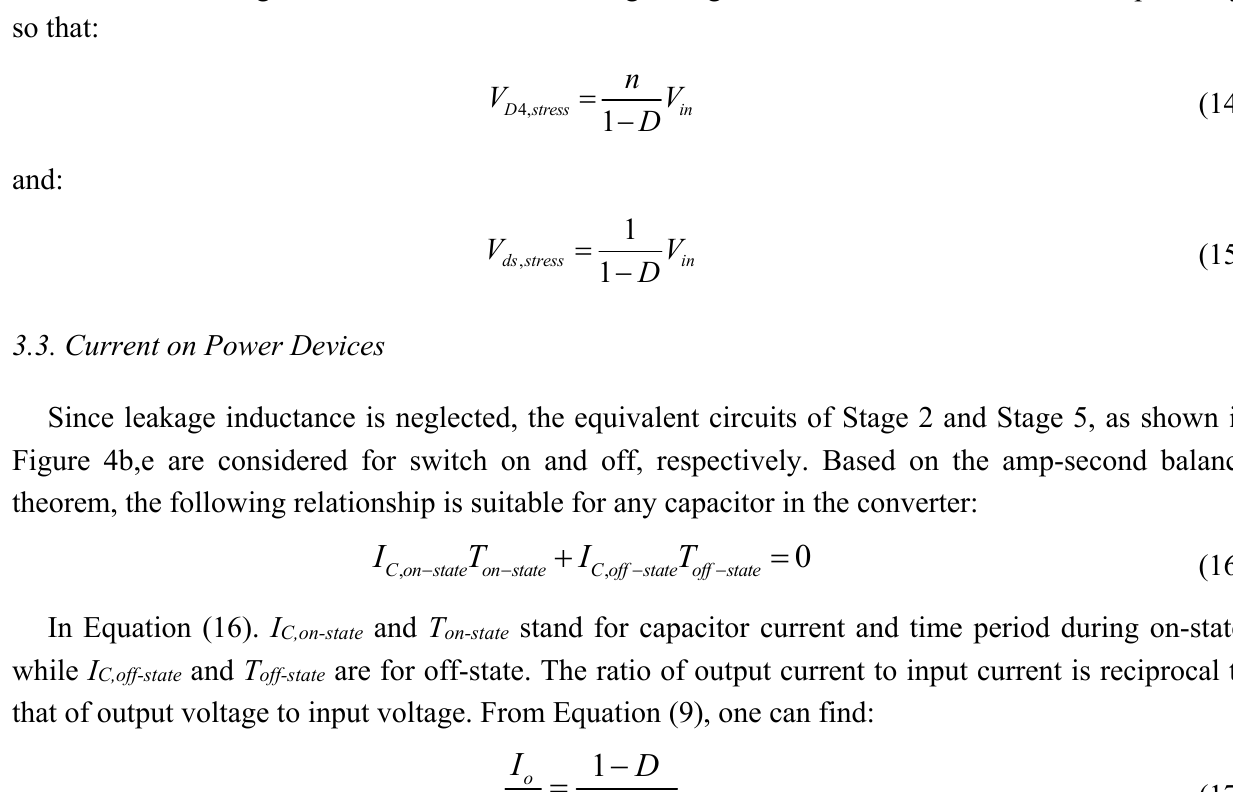
Figure 4e. From Equation (6), the sustained voltage V D 2 ,stress